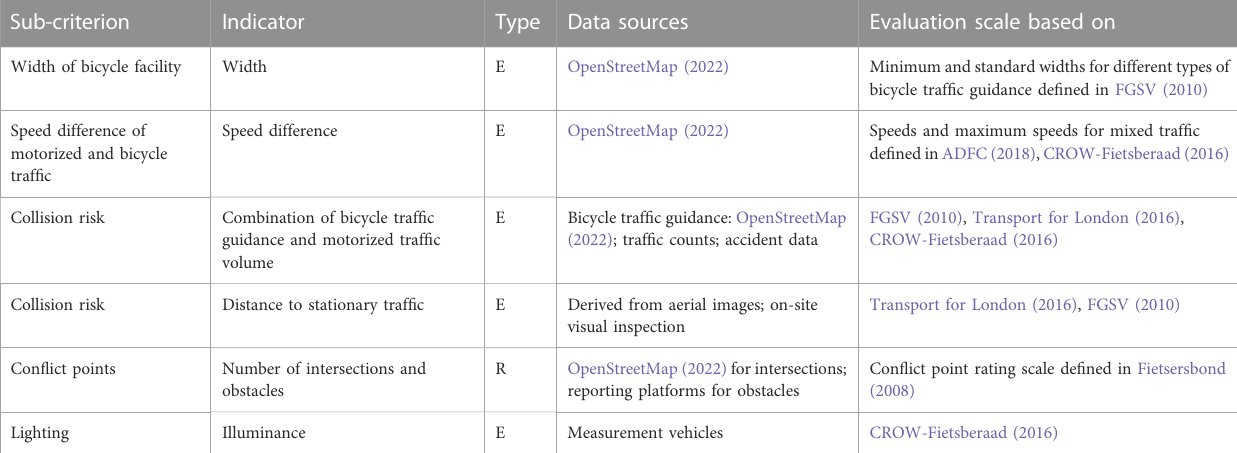
TABLE 2 Safety: sub-criteria, indicators, type of indicators (E: edge-based, R: route-based, N: network-based), data sources and sources for evaluation scales.